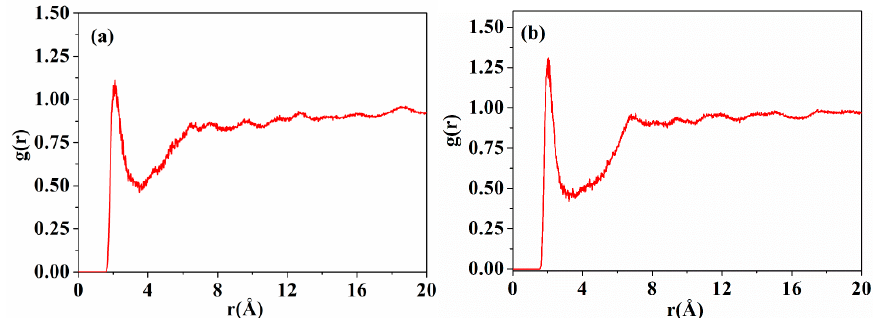
Figure 4. The RDFs of the hydrogen atoms of ‒ HN ‒ and oxygen atoms of O = C ‒ for DABPI ( a ) and m-DABPI ( b ). RDFs:Radial distribution function usually refers to the distribution probability of other particles in space given the coordinates of a given particle (how far away from the given particle).